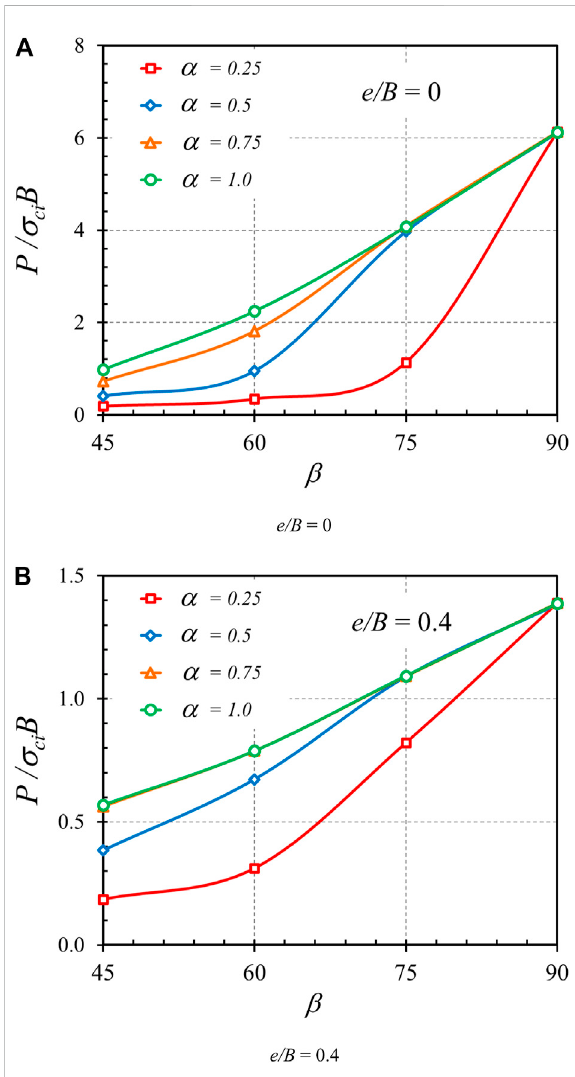
FIGURE 11 In fl uence of eccentricity, e/B on the stability solutions of bearingcapacityfactorontherockmass( GSI =100, γ B/ σ ci =0,and m i = 5). (A) α = 0.75 (B) α = 1.